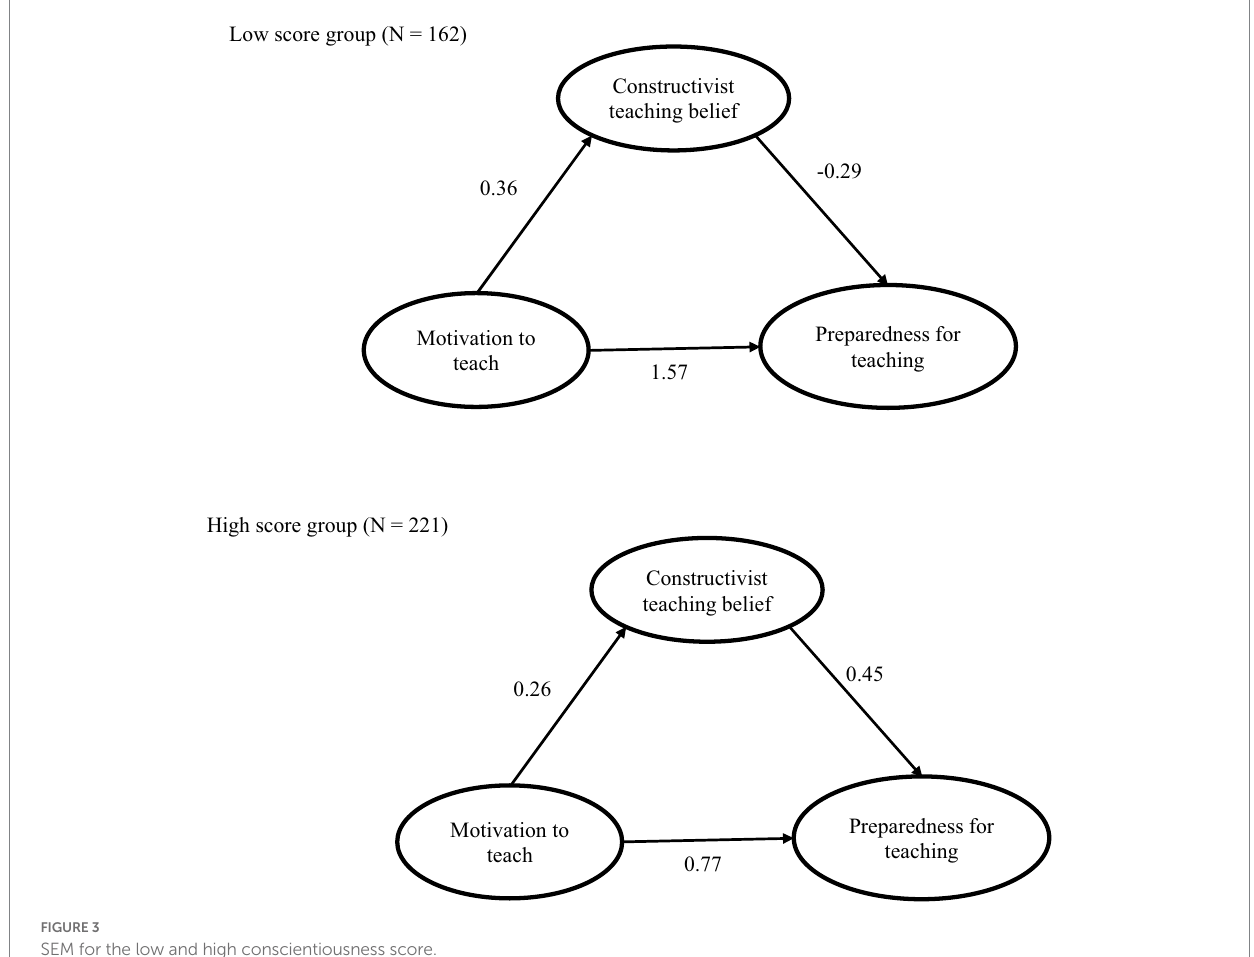
FIGURE 3 SEM for the low and high conscientiousness